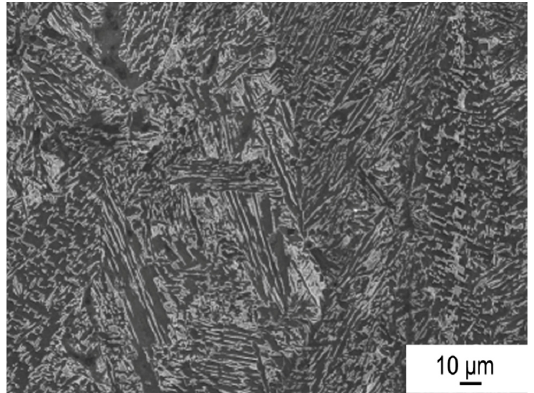
Figure 2. As ‐ cast microstructure consisting of martensite and bainite observed by scanning electron microscopy (SEM).